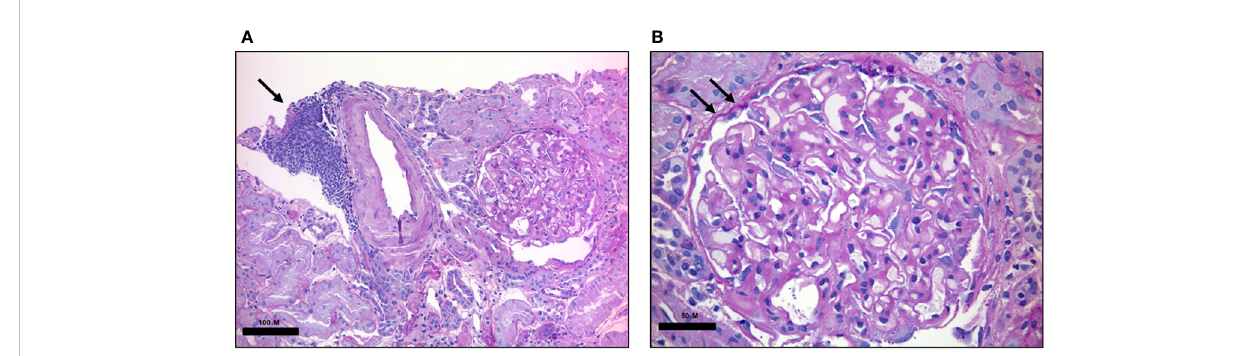
FIGURE 1 Renal histology. PAS-stained renal biopsy. (A) Low magni fi cation shows a dense lymphocytic in fi ltrate composed of small monotonous lymphocytes in aggregate (black arrow). Scale bar: 100 m M (B) High-magni fi cation highlights renal glomerulus with thickening of the basal membrane (black arrows). Scale bar: 50 m